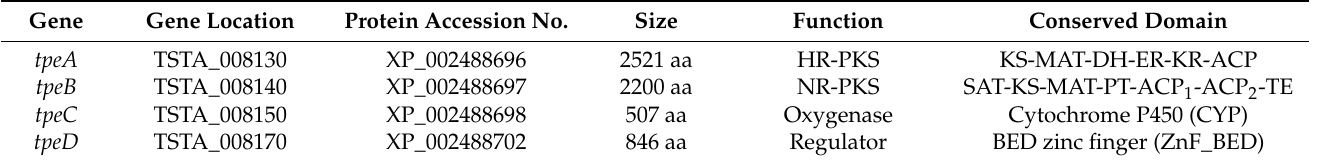
(TE) (Table 2) [32–34]. The similarity of TpeA and TpeB domains to their counterparts in Men1 and Men2 are presented in (Tables S1 and S2). Table 2. The putative proteins encoded by the proposed biosynthetic gene cluster of T. stipita- tus polyesters. Gene Gene Location Protein Accession